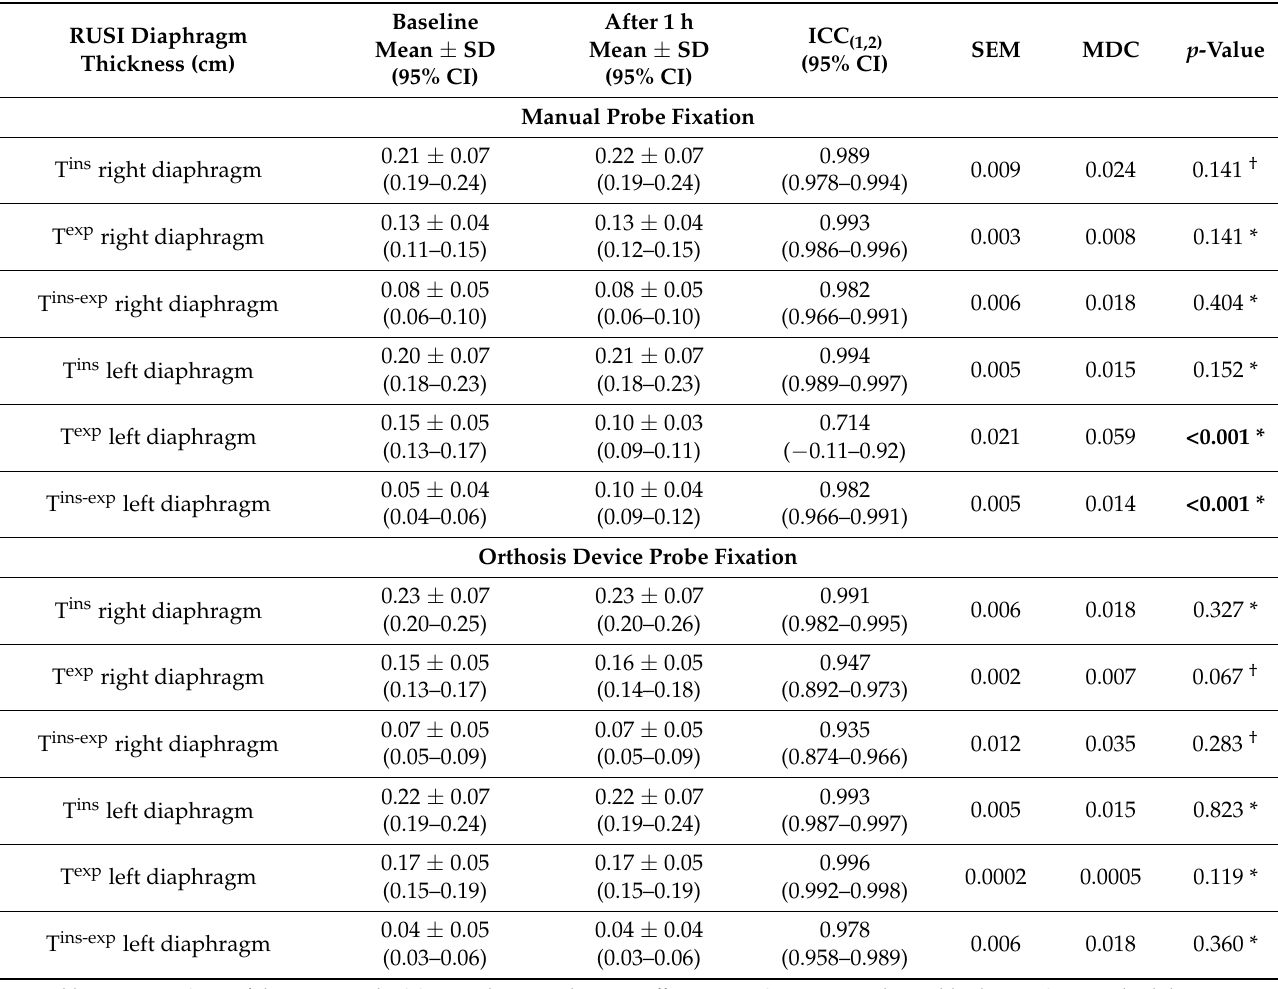
Table 1. Intra-rater and intra-session reliability analysis for RUSI diaphragm thickness within both manual and specific orthosis device measurement methods during relaxed